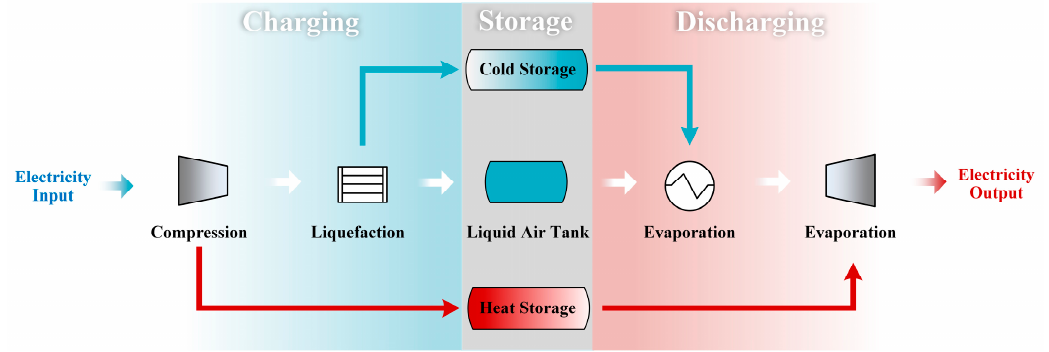
Figure 1. The simplified block diagram of the LAES system. Adapted from Ref. [11].